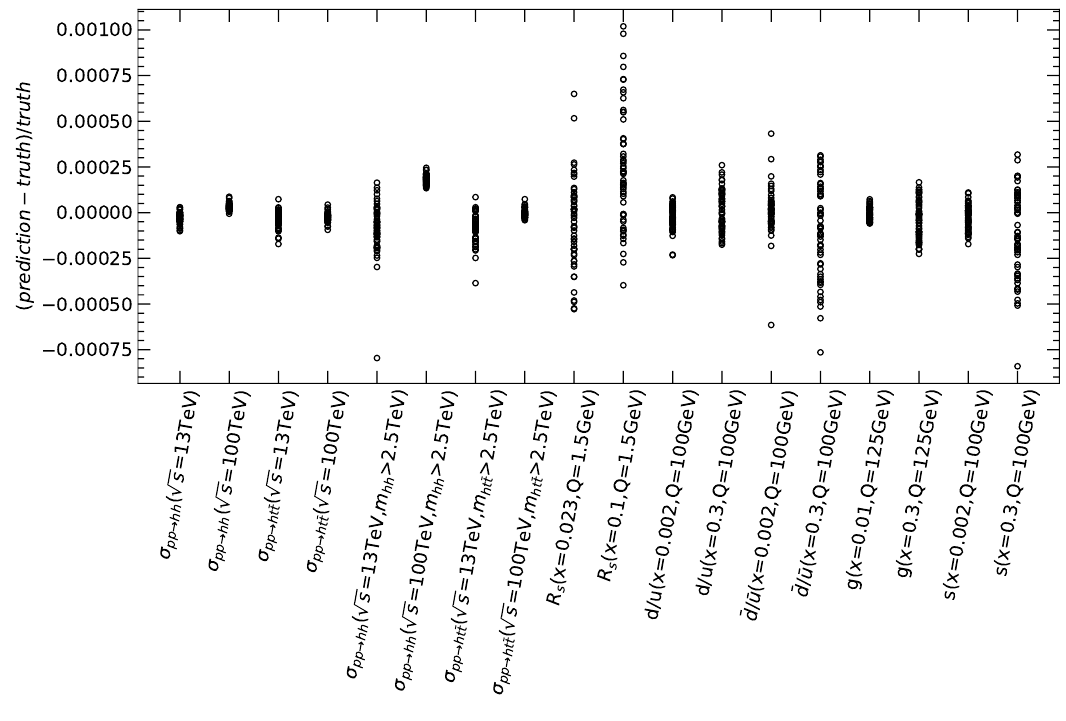
Figure 6 . The relative difference between the predictions from NNs and the truths for various physics quantities. For each physics quantity, 57 marks distributed along the vertical direction correspond to the results from 57 PDFs of CT18